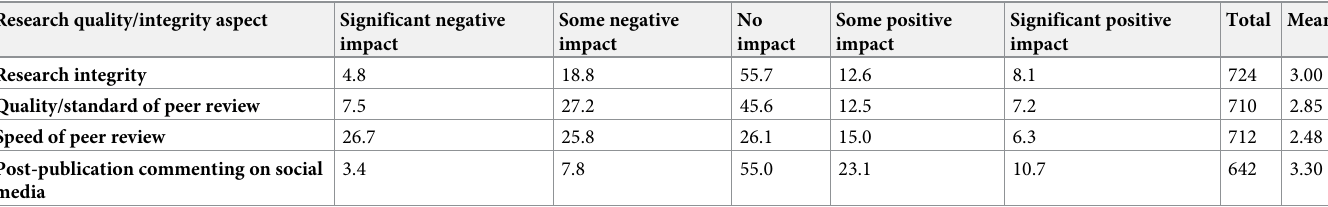
Table 10. Based on your personal experience, how has the pandemic affected the following in your field? (%). Research quality/integrity aspect